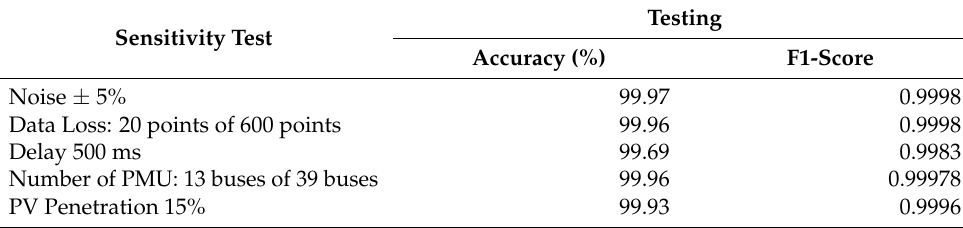
Table 12. Summary of sensitivity